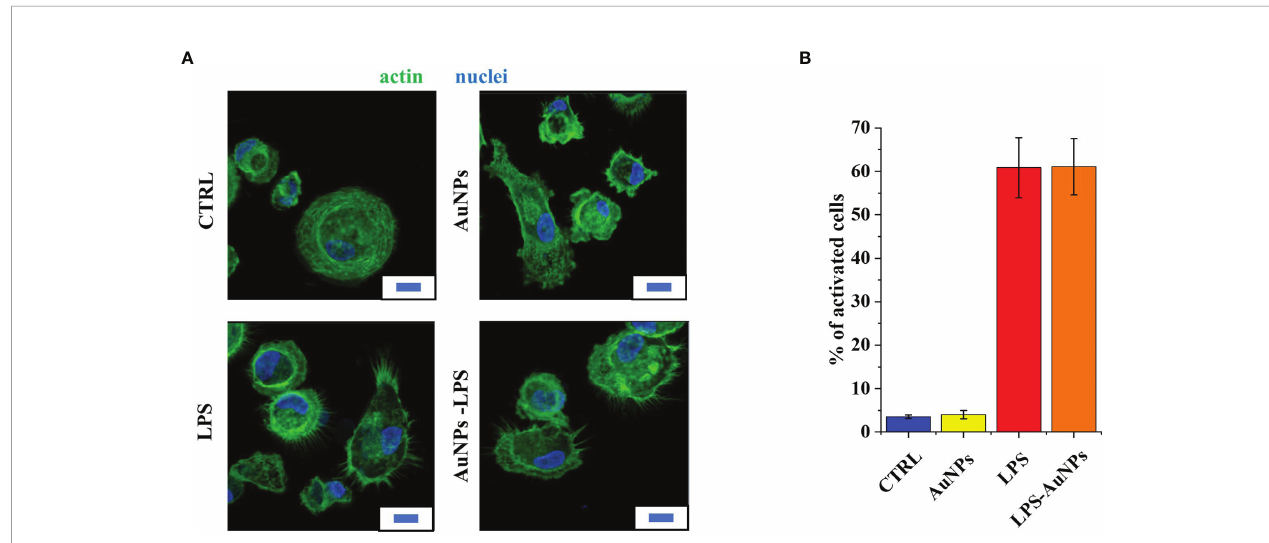
FIGURE 3 | LPS-coated AuNPs induce morphological changes in macrophages. (A) Confocal microscopy images showing the morphology of human monocyte- derived macrophages either untreated (CTRL) or exposed to 200 ng/mL free LPS, 1 m g/mL bare AuNPs (AuNPs) and 1 m g/mL LPS-coated AuNPs that contain 200 ng/mL LPS (LPS-AuNPs). The fi lamentous actin is stained in green, cell nuclei in blue. Scale bar: 10 m m. (B) Quantitative evaluation of cells with an activated phenotype for each treatment. Total cell counts for the 3 independent experiments: 2890 cells in the CTRL sample; 2744 cells in the free LPS sample; 2777 cells in the AUNP sample; 2779 cells in the LPS-AuNP sample. Mean ± SD of data from 3 independent experiments.